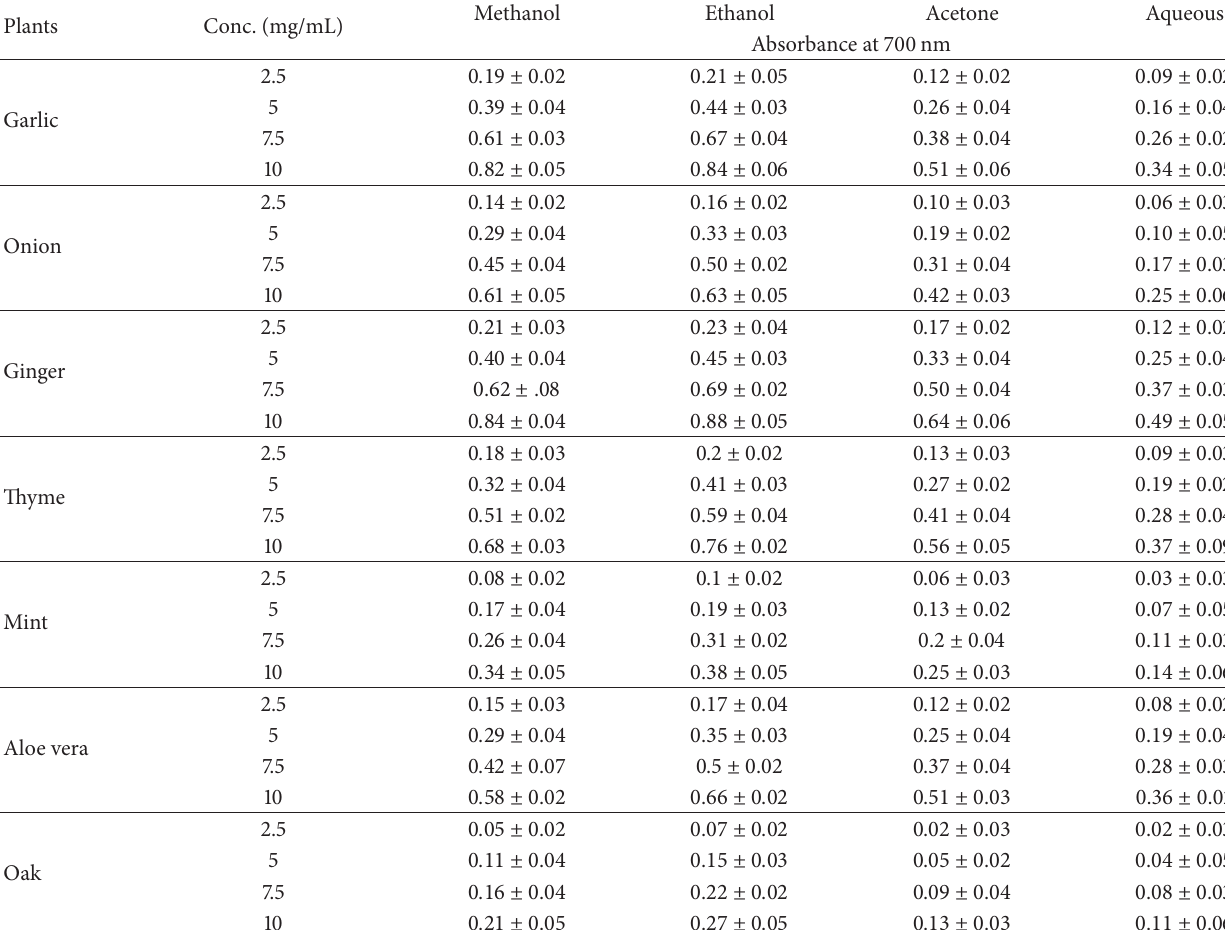
Table 2: Reducing power (in terms of absorbance values at 700 nm) of extracts from different medicinal plants. Plants